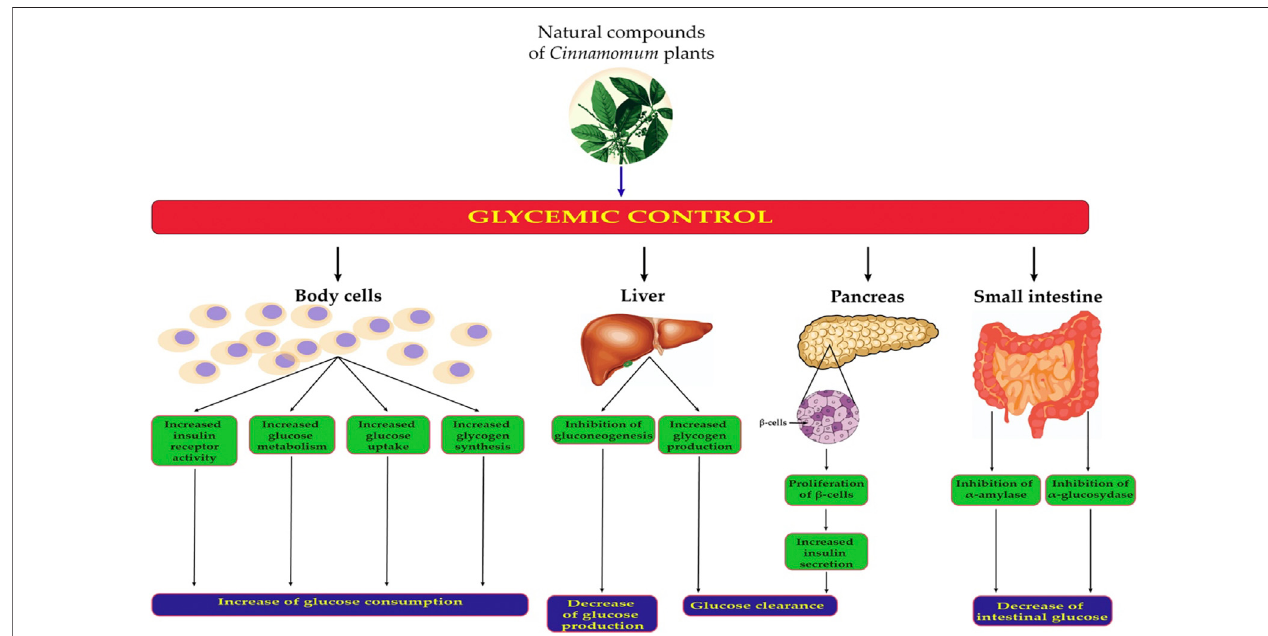
FIGURE 3 | Potential mechanisms of antidiabetic effects of chemical compounds of Cinnamomum plants. Body cells mean all the human cells with receptors for insulin.